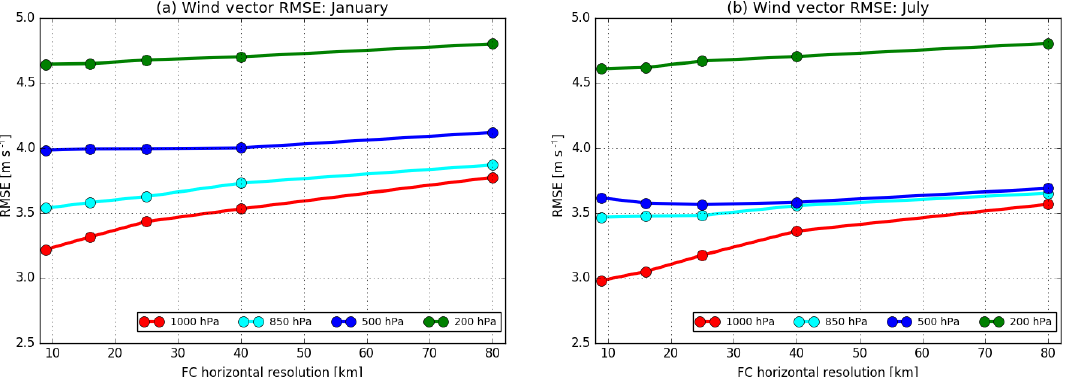
Figure 4. Mean RMSE of vector wind (ms − 1 ) at different model resolutions in (a) January and in (b) July for around 400 radiosonde stations over the globe. Different colours represent different pressure levels (see legend). All the model simulations are based on the standard 1d forecast configuration shown in Fig. 3. Note that the number of data at the 1000hPa level might be slightly smaller than at the other pressure levels, as the observations at 1000hPa are not available when the surface pressure is lower than 1000hPa.